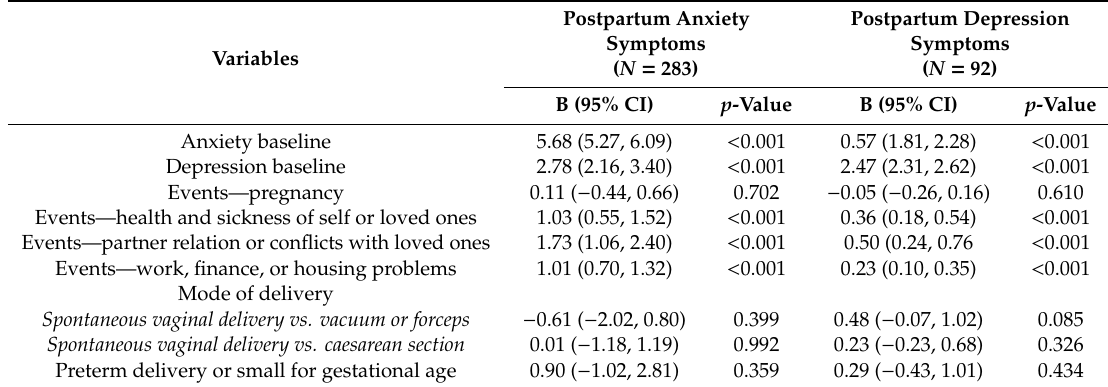
Table 2. Associations of postpartum levels of anxiety and depression with antenatal symptoms, specific life events, and delivery complications. N =